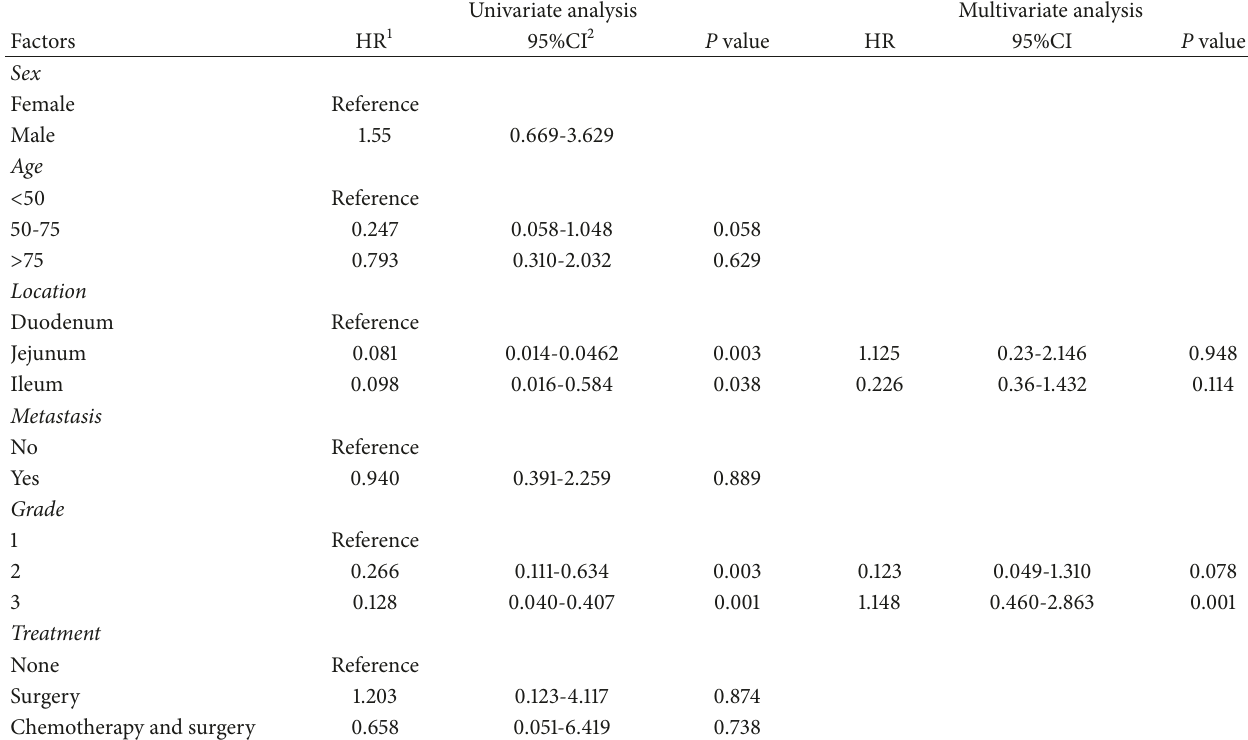
Table 2: Univariate and multivariate Cox regression